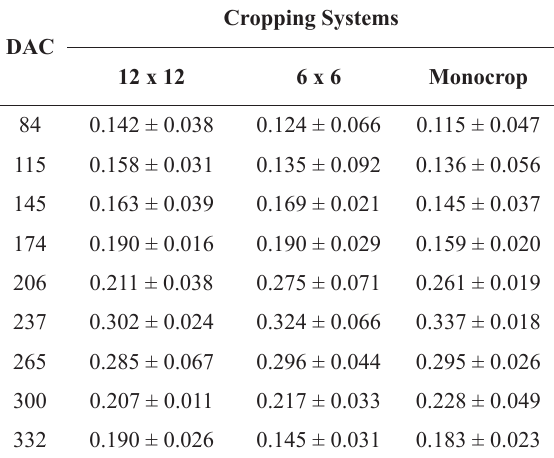
Light extinction coefficient with (± standard error) in different cropping systems of sugarcane cultivation throughout the days after cutting